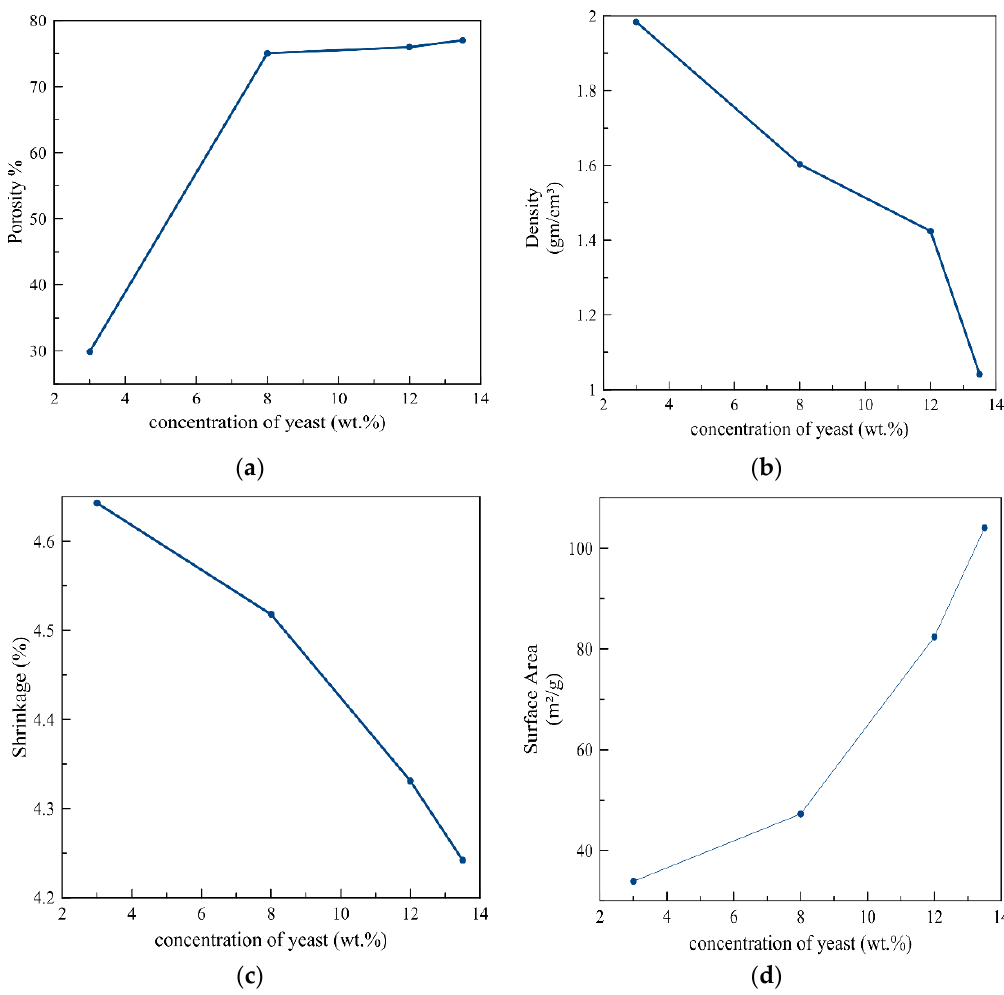
Figure 4. Simulated e ff ect of the concentration of yeast on: ( a ) Porosity, ( b ) density, ( c ) Shrinkage, and ( d ) Surface area.